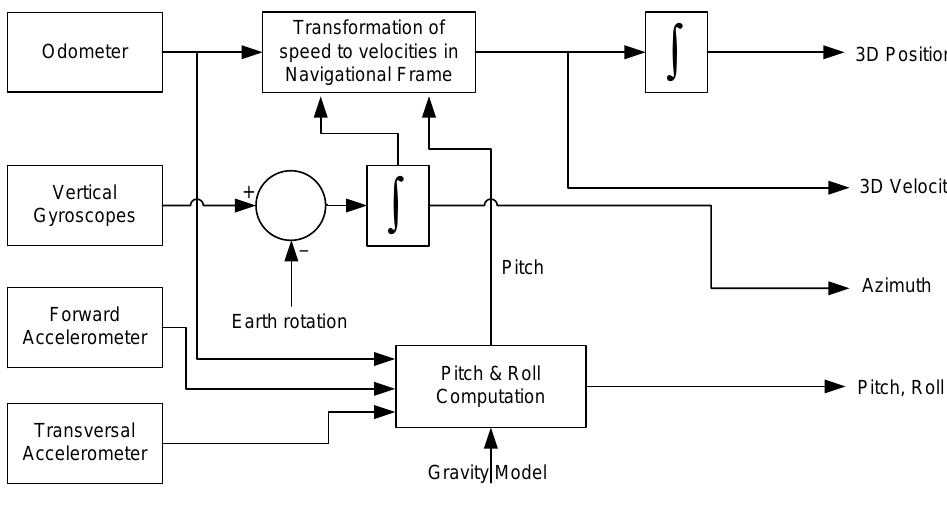
Figure 3. 3D RISS mechanization block